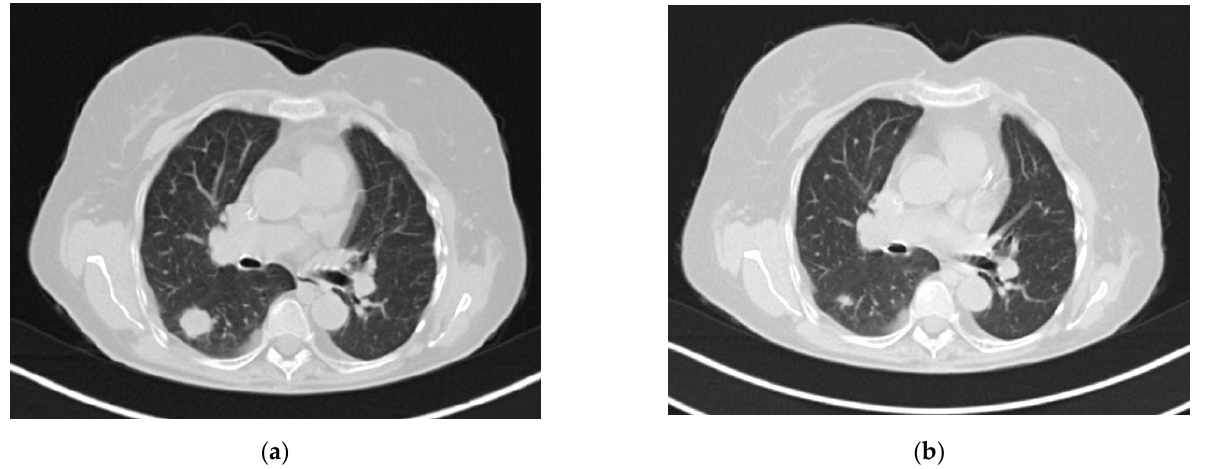
Figure 2. ( a ) Presentation CT scan of Case 2; ( b ) CT scan after antifungal